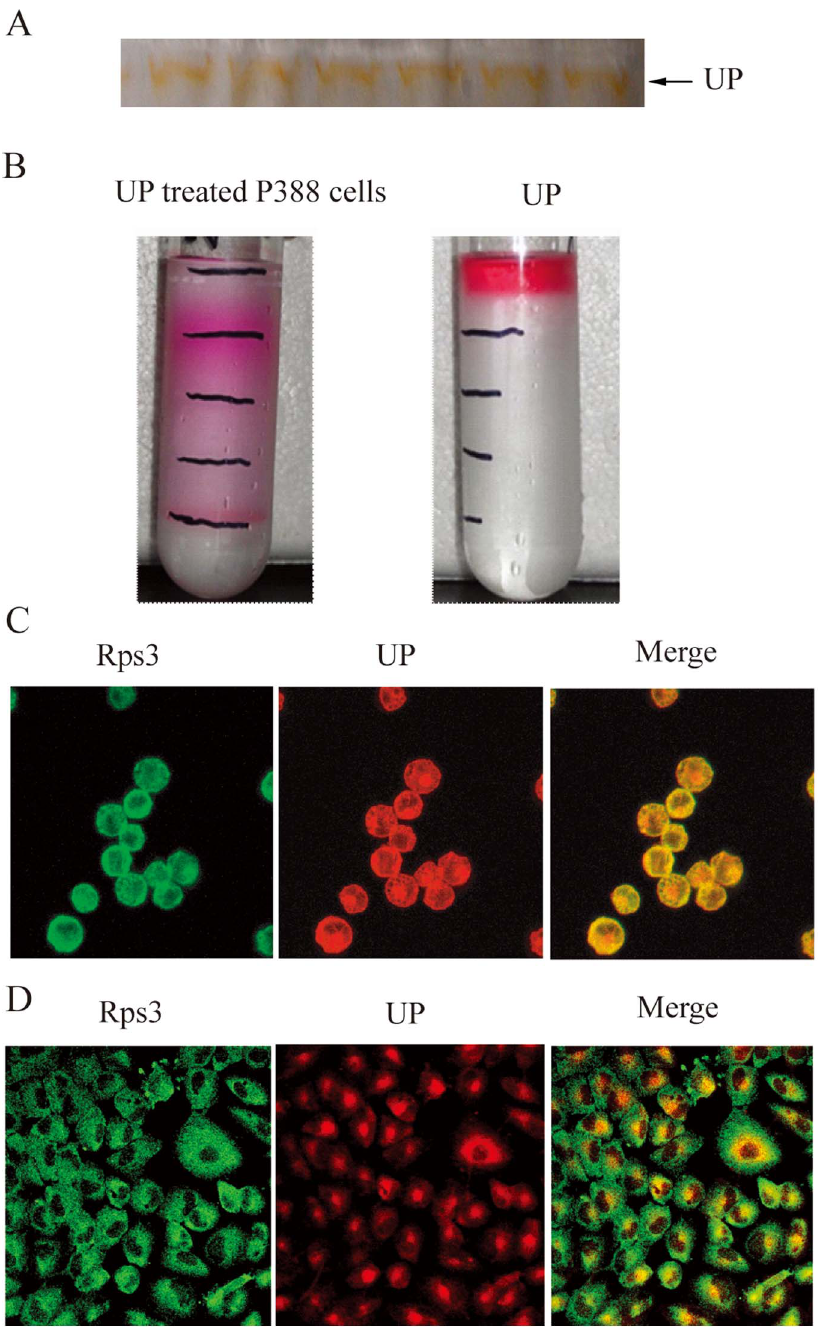
Figure 8. UP binds to the ribosome. A . The strip of UP in Native–PAGE. B . Sucrose density gradient fractionation of UP-treated P388 cells and UP alone. C and D. Subcellular localization of Rps3 and UP in P388 cells (C) and A549 cells (D) detected by confocal. UP fluorescence is shown in red, Rps3 fluorescence in green and the colocalization (merge) in yellow.